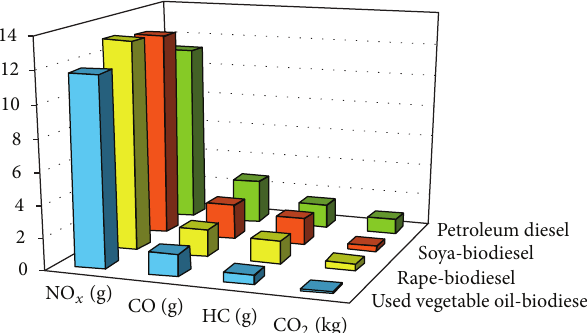
Figure1:Emissionofexhaustgasesbytrucksperonekmforvarious fuels.